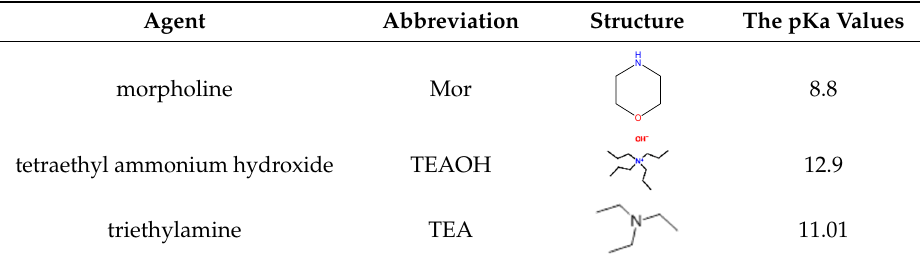
Table 9. The structure of the three templating agents and the values of pKa [31]. Agent